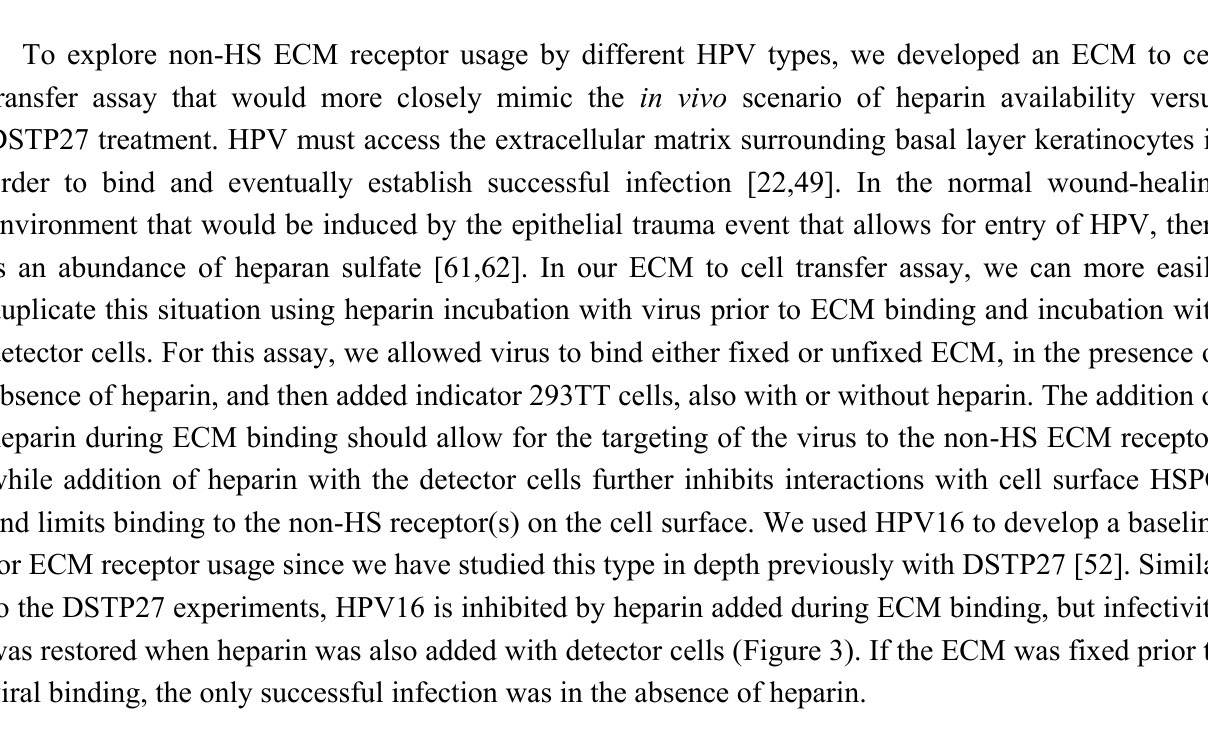
Figure 2. HPV16 utilizes LN332 to bind to the ECM in the presence of heparin. ( A ) Virus was allowed to bind to the ECM in the presence of heparin (10 g/mL). The ECM was either untreated or treated with LN332 polyclonal antibody prior to viral binding. Virus (green) was detected using 33L1-7, after denaturation, and ECM (red) was detected with LN332 antibody; ( B ) LN332 subunits were knocked down using siRNA in HaCaT cells; ( B.1 ) Western blot for LN332 and Actin in control and siRNA treated cells. Protein levels were determined from blot image using densitometry with actin as a loading control; ( B.2 ) Wt HPV16 virus was incubated in the presence of heparin at a 10 μg/mL, added to control and LN332 KD HaCaT cells. Cell nuclei are stained with DAPI (blue) and virus is detected with 33L1-7 (green); ( B.3 ) The proportion of cells possessing a ring of virus bound to the secreted ECM of control and LN332 KD HaCaT cells were